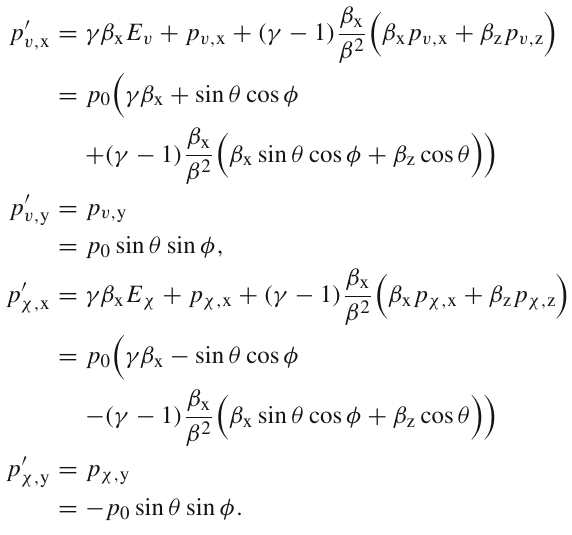
Fig. 2 Values of m (cid:3) normalised to m plotted as a function of γ for T / m at γ = 1 for θ = 0 . 9 different values of θ and φ . The value of m (cid:3) T is sin θ = 0 . 783. The maximum value of γ for θ = 0 . 9 and φ = 0 for which m (cid:3) is non-zero is γ = 1 / cos θ = 1 . 609. The curve in this case (cid:2) T / m = / m for has equation m (cid:3) 1 − 0 . 386 γ 2 . The limiting value of m (cid:3) T T θ